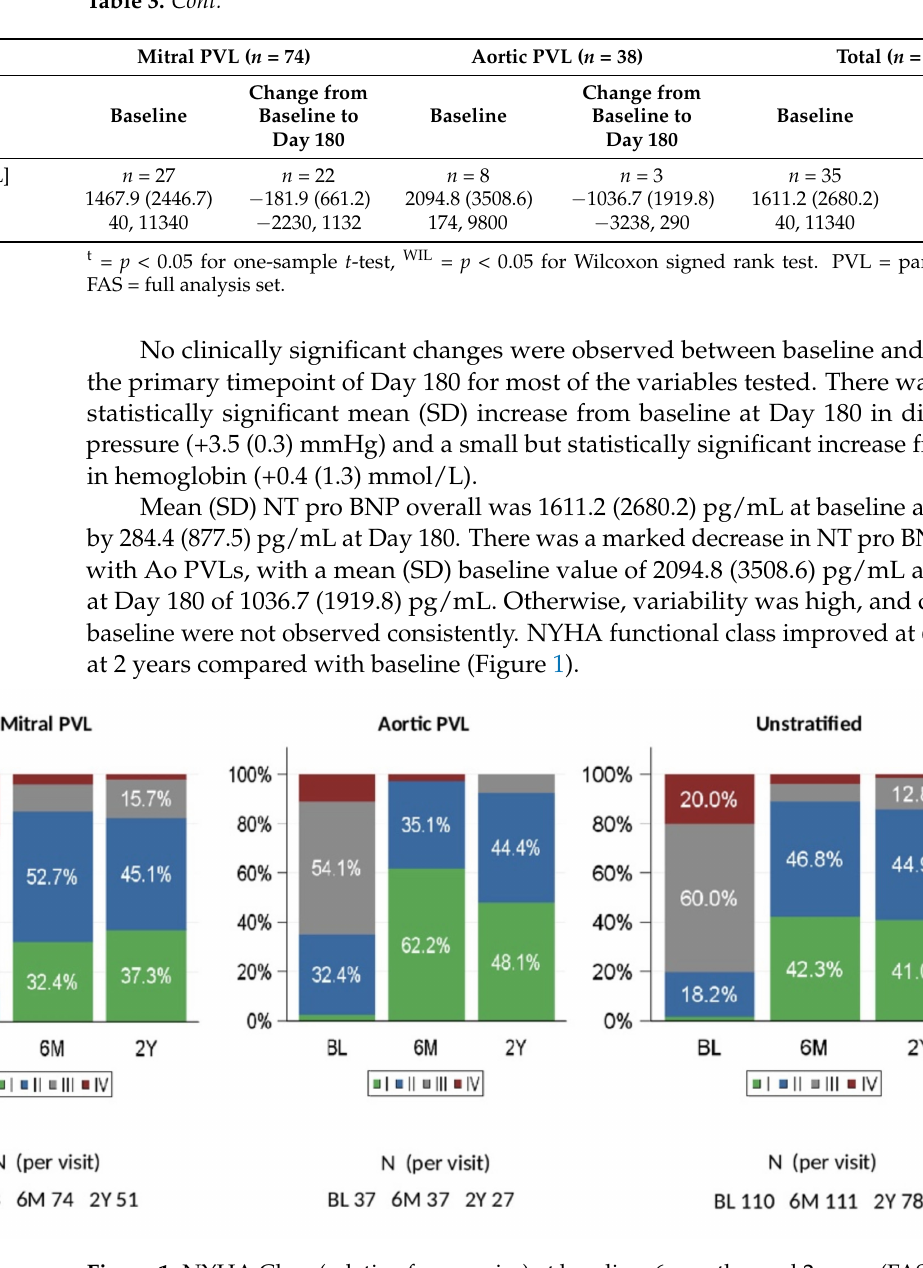
Figure 1. NYHA Class (relative frequencies) at baseline, 6 months, and 2 years (FAS). BL: baseline, 6M: 6 months; 2Y: 2 years. NYHA = New York Heart Association. PVL = paravalvular leak. FAS= full analysis